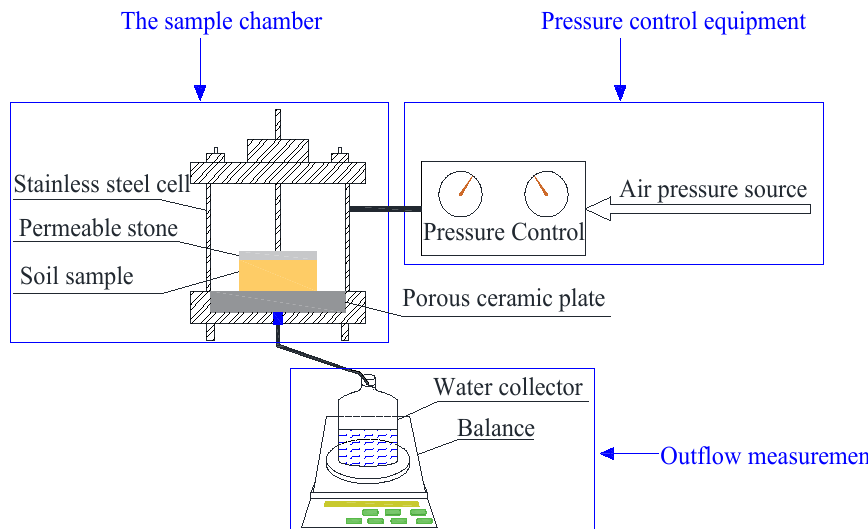
Figure 4. General scheme of the soil–water characteristic curve test system.